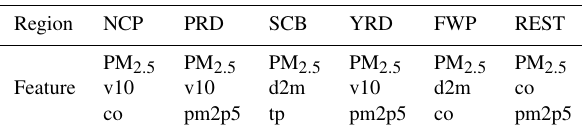
Table 6. Summary of selected